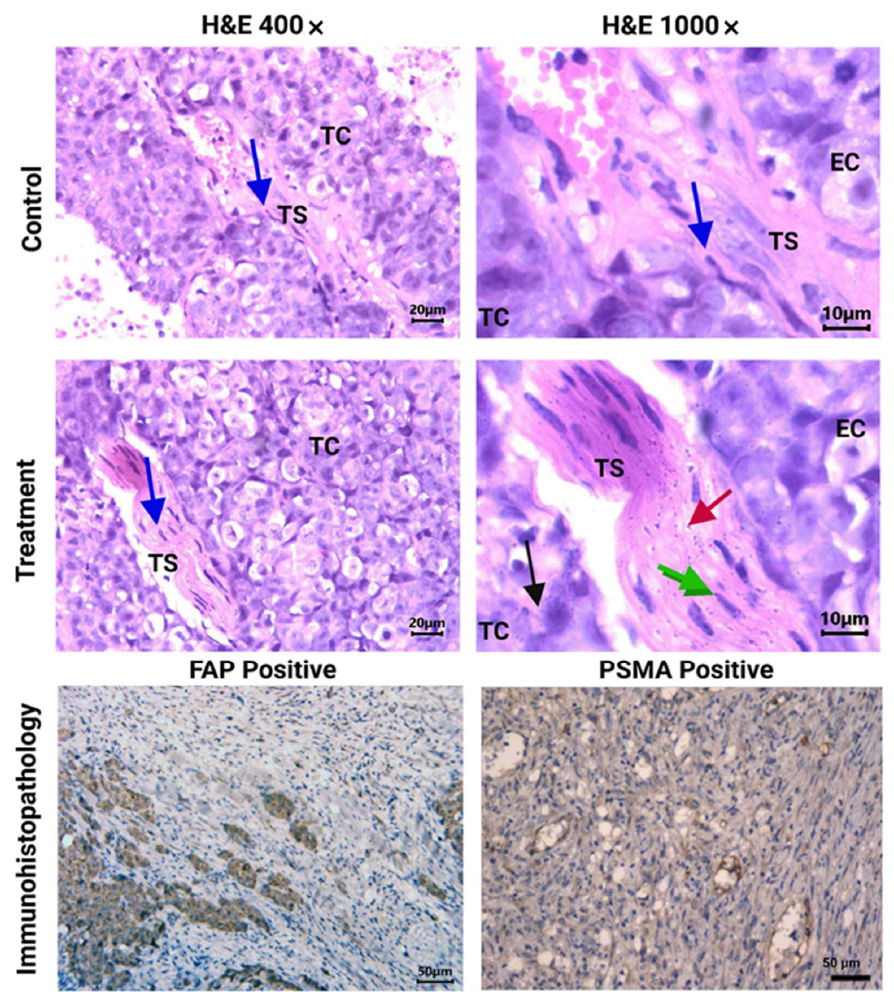
Figure 6. Histopathological analysis (H&E staining). Light micrographs of representative sections at 400 × and 1000 × magnification of HCT116 tumors from [ 177 Lu]Lu − iFAP/iPSMA-treated and untreated (control) mice. Cancer-associated fibroblasts (CAFs) can be observed in the tumor stroma (TS) (blue arrow). Note nanoparticle clusters of [ 177 Lu]Lu − iFAP/iPSMA in TS (red arrow), in CAFs (green arrow), and in tumor cells (TC) (black arrow), but not found in endothelial cells (EC). PSMA and FAP expression in HCT116 tumors (dark brown color) (200 × magnification of) is also shown (immunohistopathology